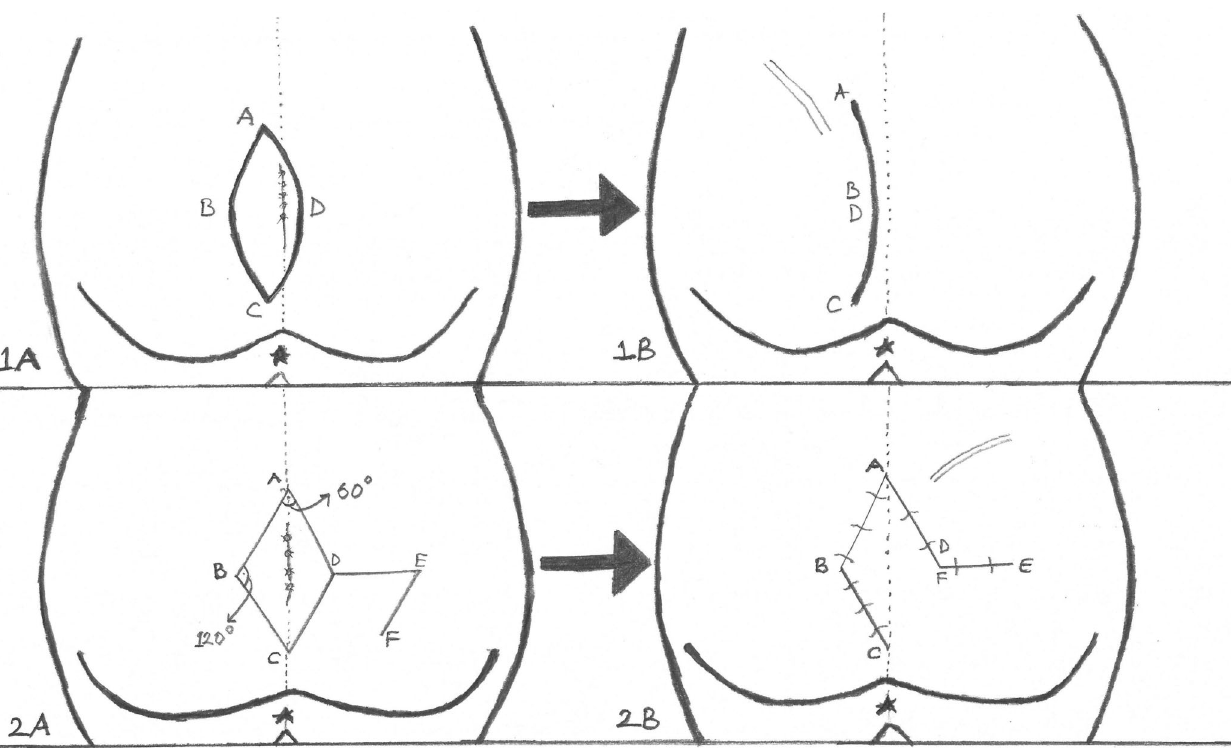
Figure 1 - Asymmetric elliptical excision (1A) . Closure of the cavity with Karydakis flap (1B) . Rhomboid excision (2A) . Limberg flap and construction after rhomboid excision (2B)